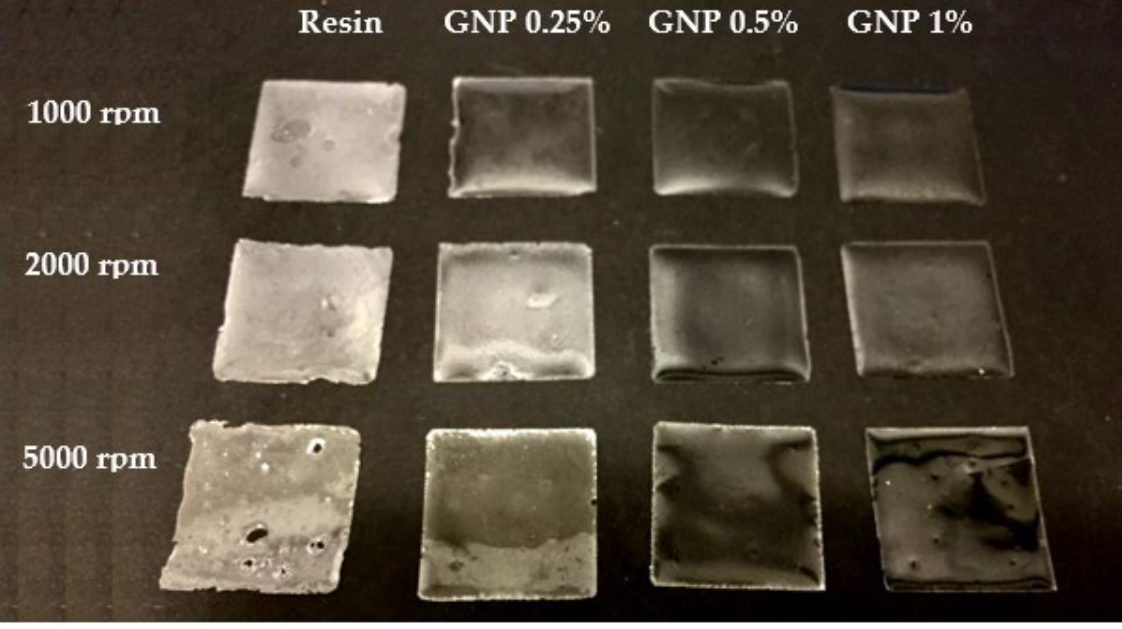
Figure 19. Overview image of all samples subjected to 31-day sulfuric acid aging, organized with respect to thickness and nanofiller concentration.